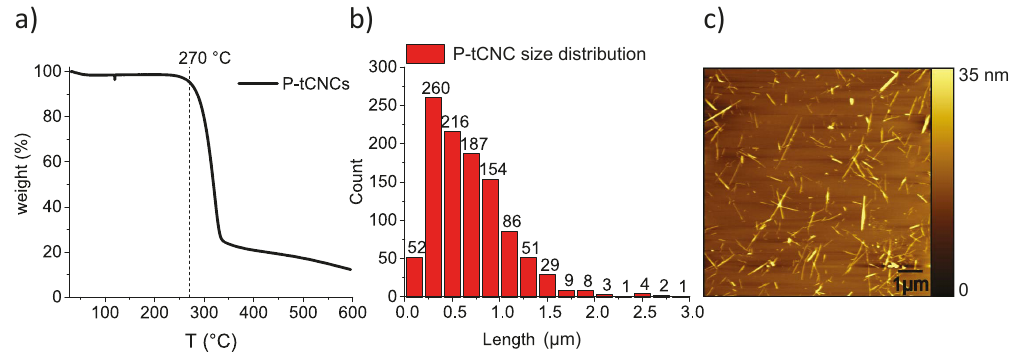
Figure 2. ( a ) The TGA of phosphoric acid-hydrolyzed cellulose nanocrystals from tunicates (P-tCNCs) shows an onset of degradation at 270 °C. ( b ) Size distribution of P-tCNCs as determined from AFM image analysis. ( c ) AFM image of P-tCNCs showing nanocrystals of comparably high aspect